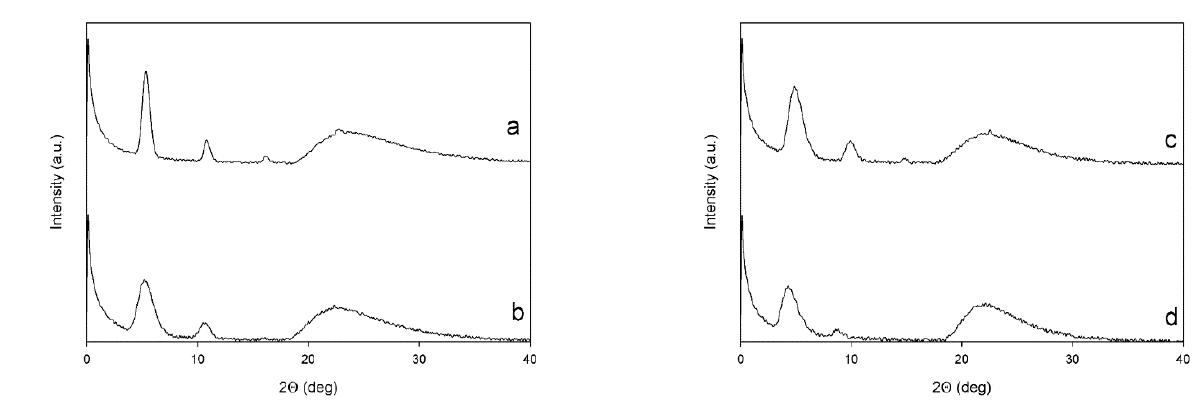
Figure 5. X-ray diffractograms of PT6Br ( a ), PT6buP + ( b ), P[(T6Br)- co -(T6F)] ( c ) and P[(T6buP + )- co -(T6F)] ( d ). Table 4. Structural parameters of samples.